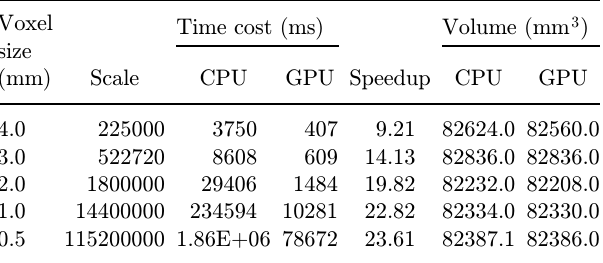
Table 2. Analysis of the reconstruction speed using the CPU versus the GPU. In this table, the performance of the recon- struction module is compared for the CPU and GPU devices. The data shown in the table are obtained from the same plant. Scale is the number of voxels